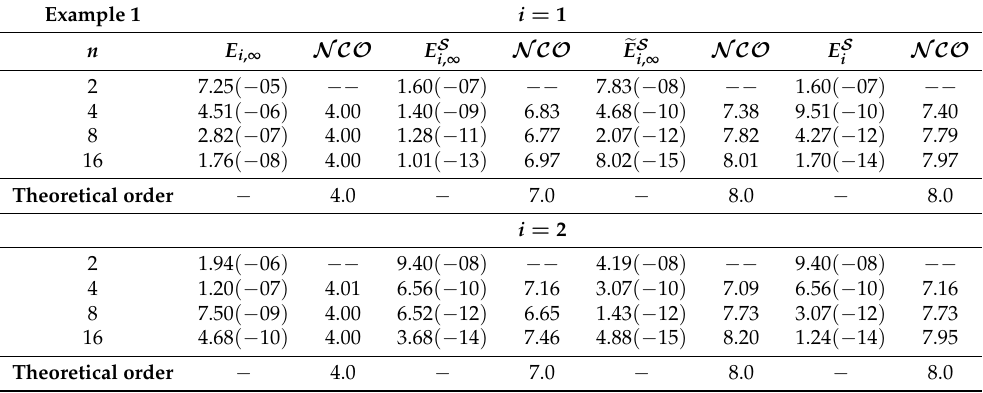
Table 3. Numerical methods based on piecewise linear functions ( r = 2 )